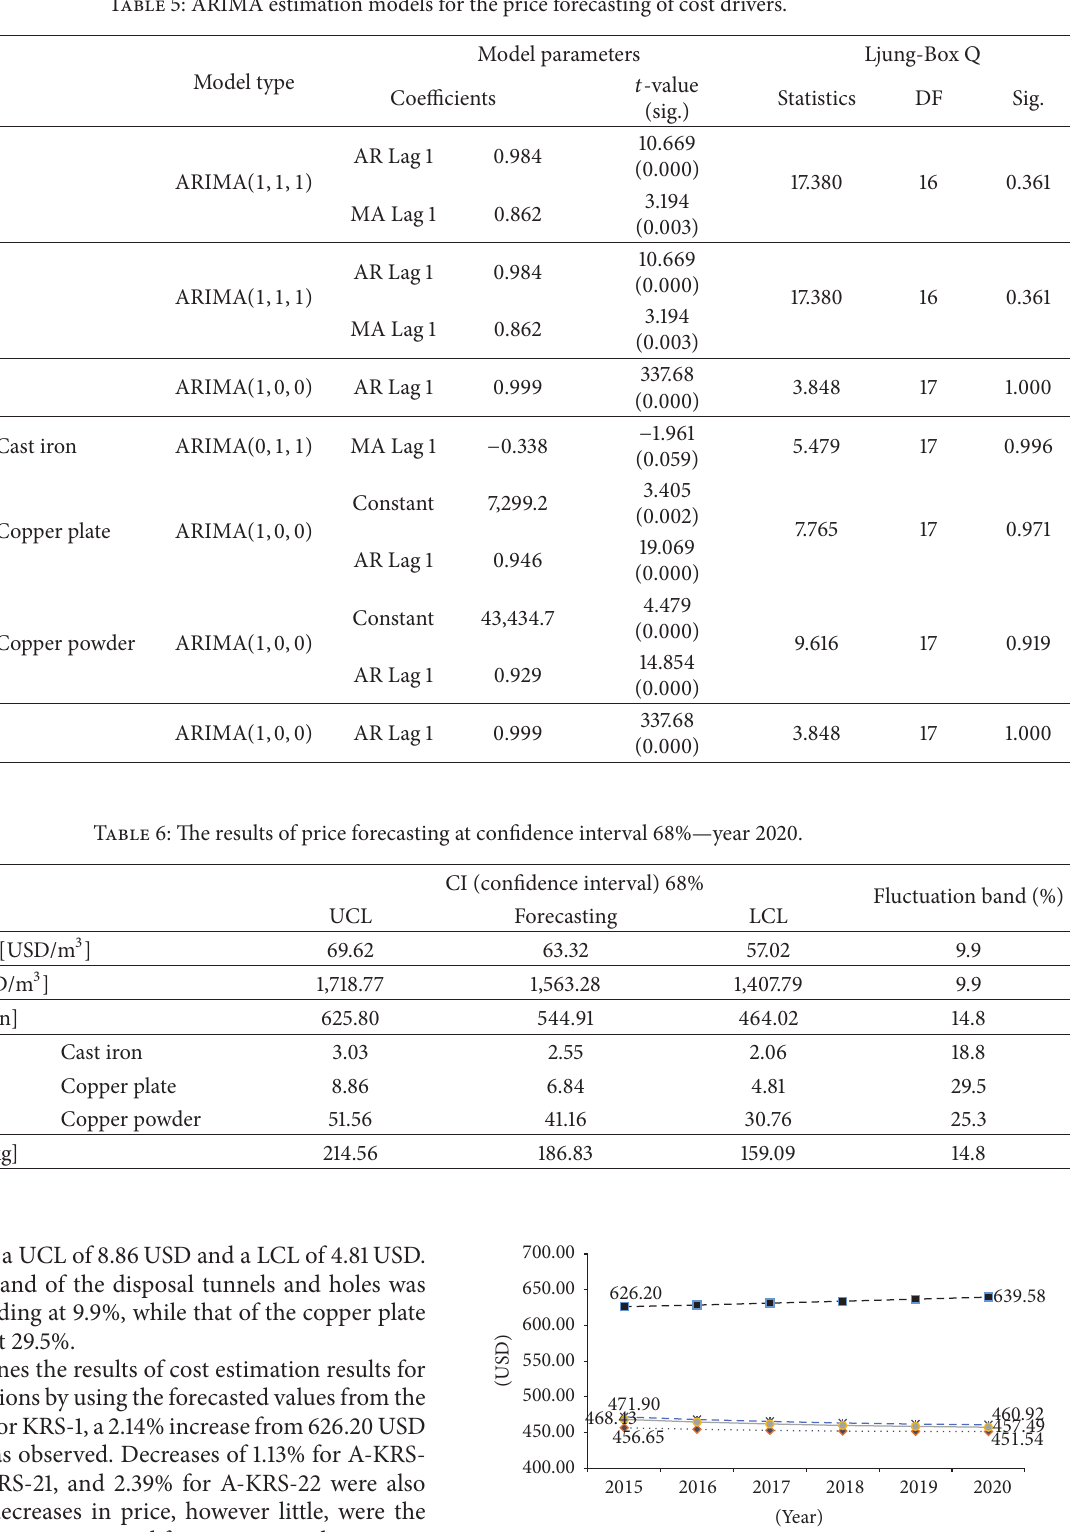
Table 5: ARIMA estimation models for the price forecasting of cost drivers.